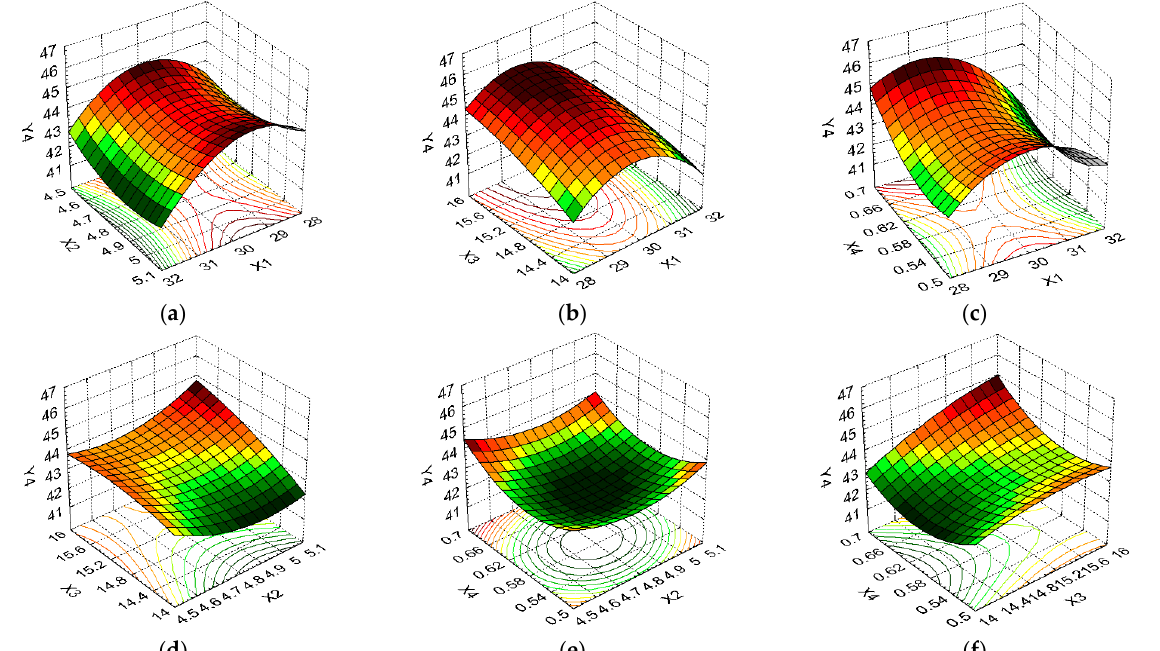
Figure 8. 3D response surface and contour plot showing the effects of different cultivation conditions on the response regarding protein content (Y 4 ): ( a ) temperature (X 1 ) and pH (X 2 ); ( b ) temperature (X 1 ) and carbon source (X 3 ); ( c ) temperature (X 1 ) and nitrogen source (X 4 ); ( d ) pH (X 2 ) and carbon source (X 3 ); ( e ) pH (X 2 ) and nitrogen source (X 4 ); and ( f ) carbon source (X 3 ) and nitrogen source (X 4